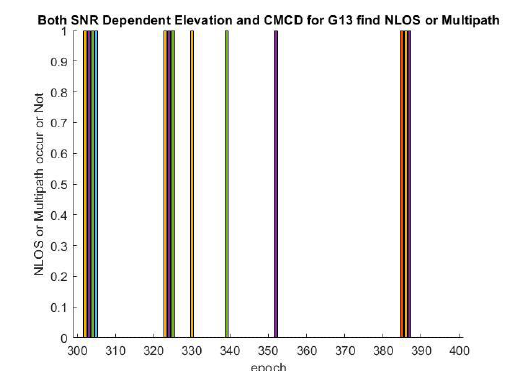
Figure 18. Both SNR Dependent Elevation and CMCD find NLOS or Multipath for G13 ( In this figure, if both criteria detect multipath or NLOS bar shows 1, and if their performance is not the same shows 0. Also, in this figure, colors do not have a special meaning. )